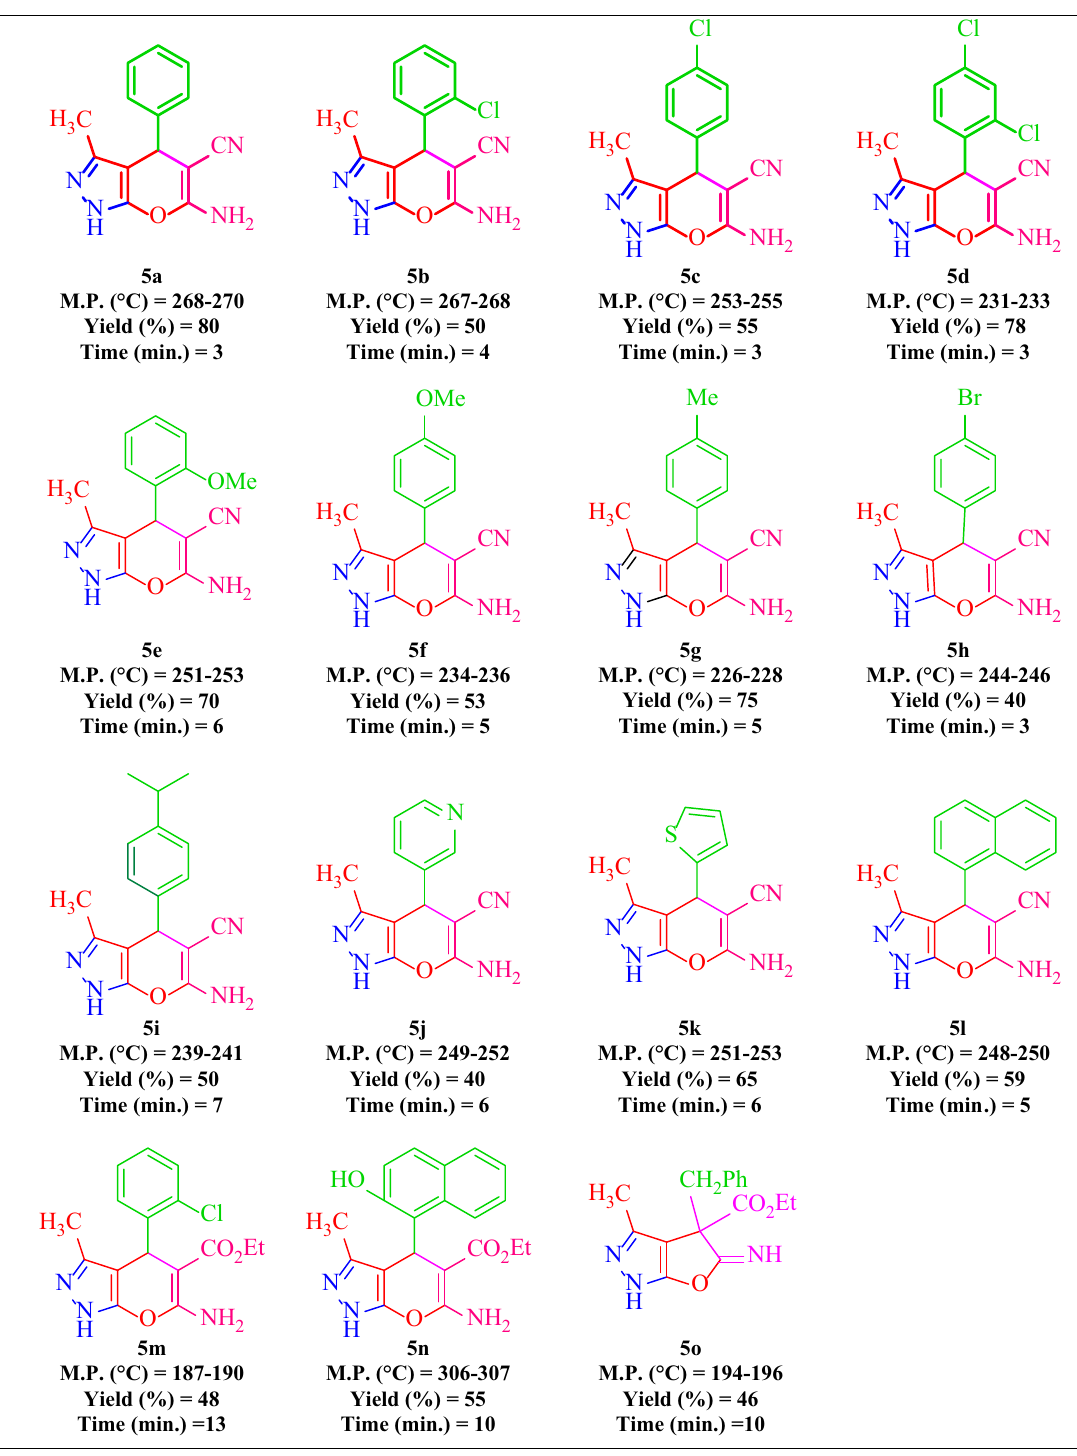
Table 5. Synthesis of pyranopyrazoles 5(a-n) by application of the FSiPSS nano-catalyst. Reaction conditions: ethyl acetoacetate (1.0 mmol), hydrazine (1.0 mmol), aldehyde (1.0 mmol), malononitrile or ethyl cyanoacetate (1.5 mmol) and the FSiPSS nano-catalyst (20 mg) in EtOH (3.0 mL) under ultrasonic